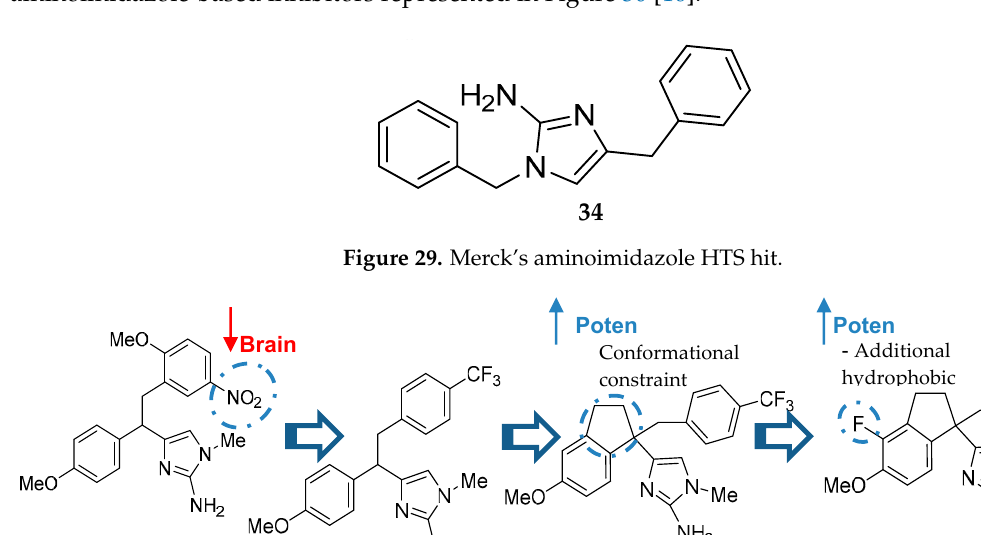
Figure 29. Merck’s aminoimidazole HTS hit.